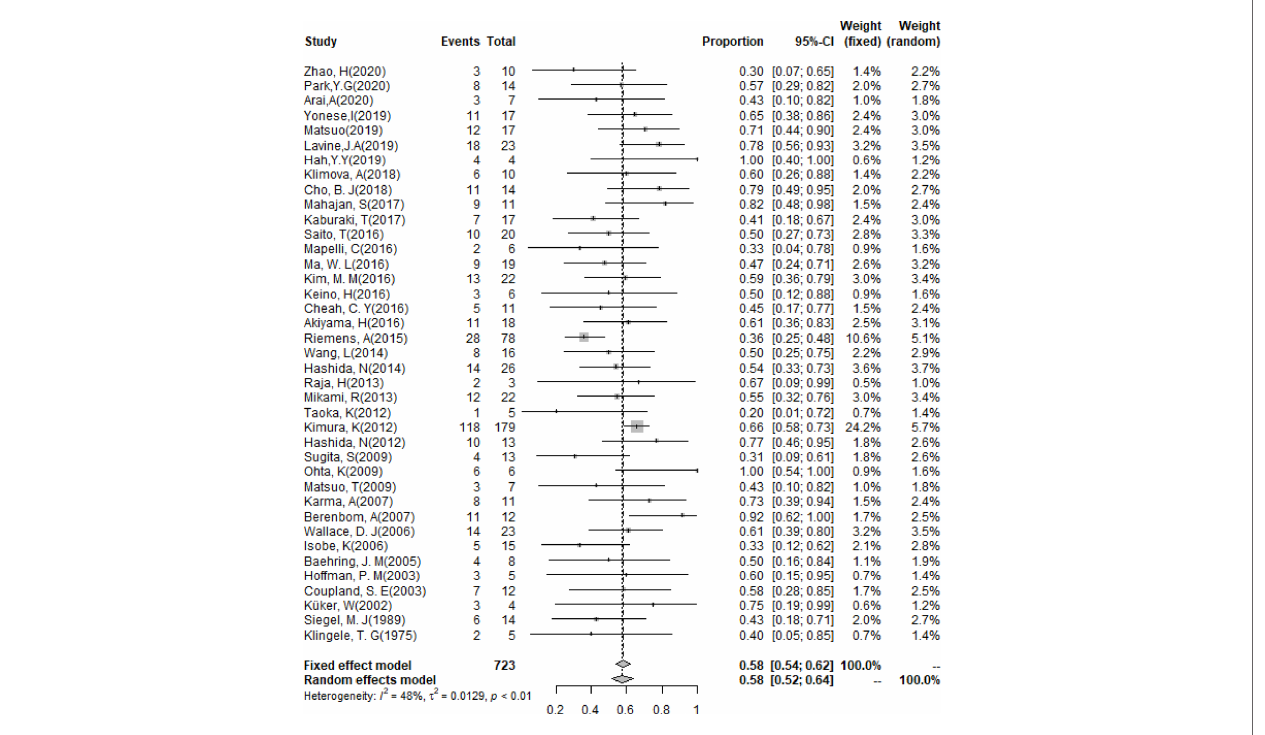
FIGURE 3 | Forest plots of CNS involvement rate during